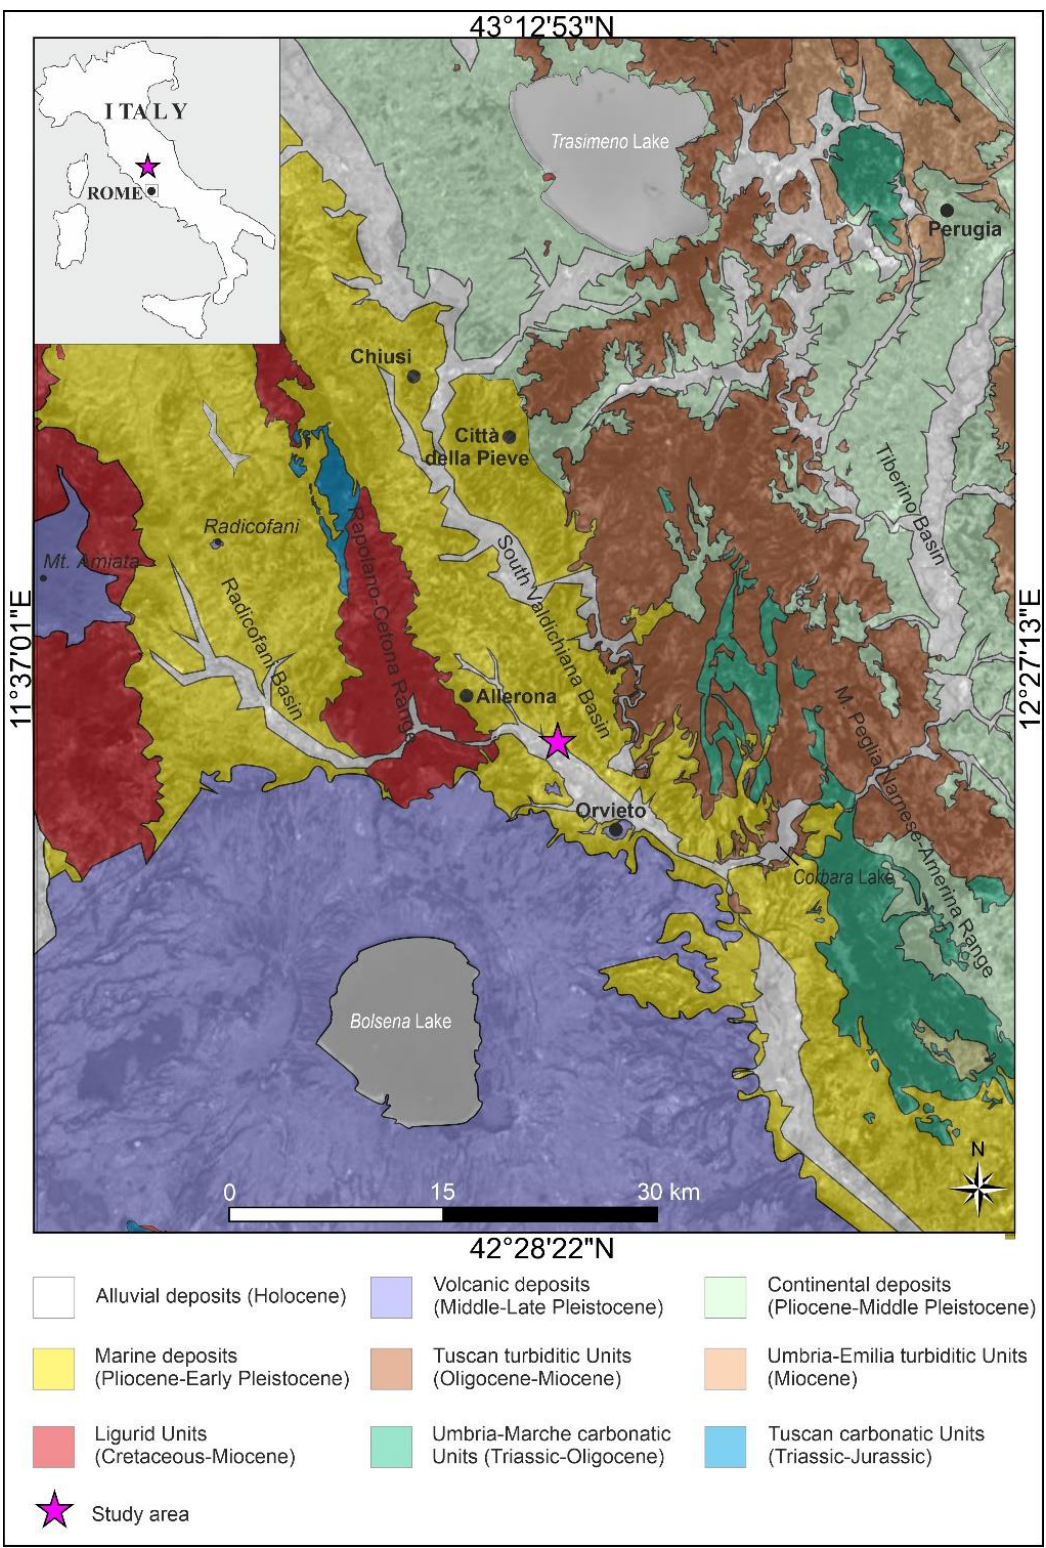
Figure 1. Simplified geological map of the study area (modified after [28]). In the inset, the position within Italy is shown.